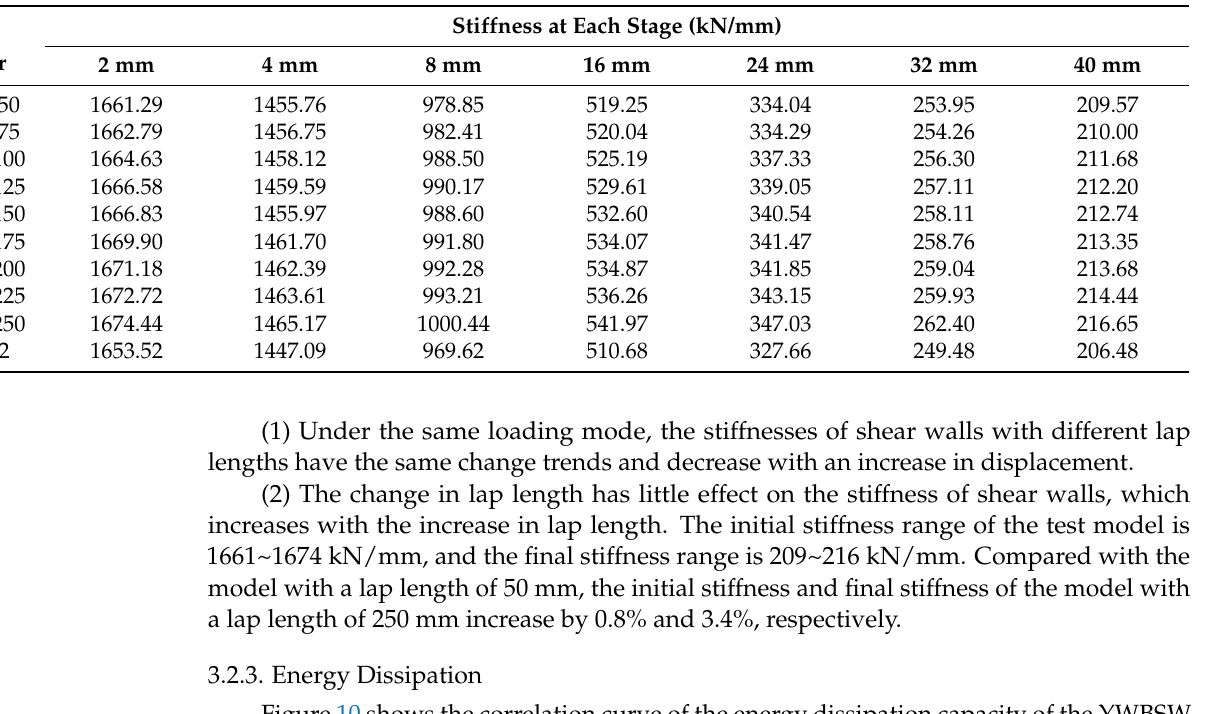
Table 10. Stiffnesses of models with different lap lengths.